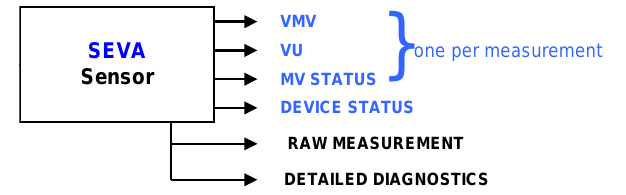
Figure 7. A SEVA sensor generating measurement and validity